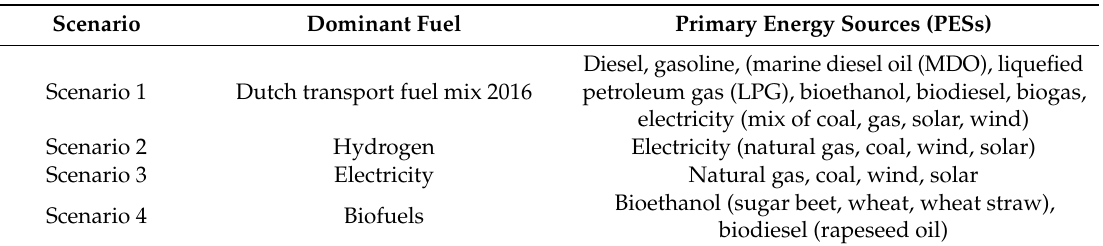
Table 1. Four scenarios, fuels and primary energy sources included in this